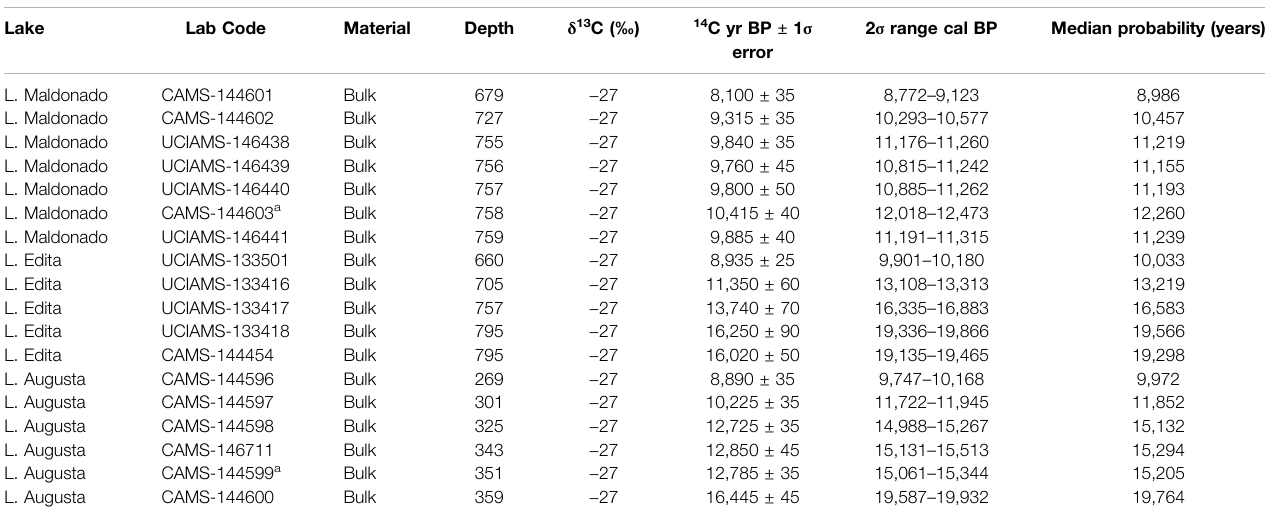
TABLE 3 | AMS radiocarbon dates from sediment cores and calibrated